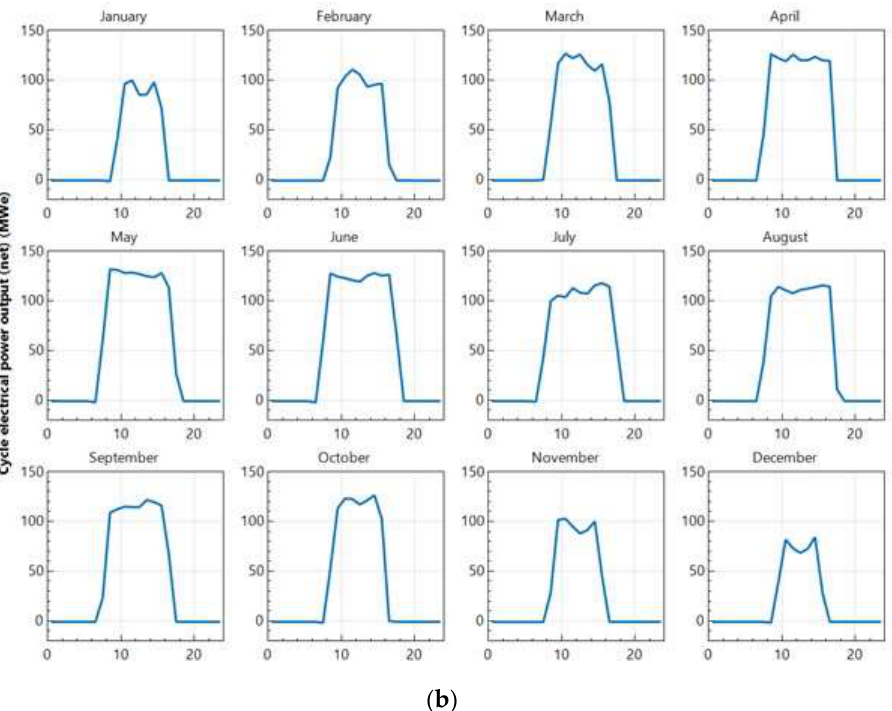
Figure 4. Genesis solar facility. ( a ) Computational thermal power produced by half the solar field and thermal power input to half the power cycle and ( b ) computational net power output from one of the two turbines in the average day of every month. X is the time of the day in hours and Y the power in MW.